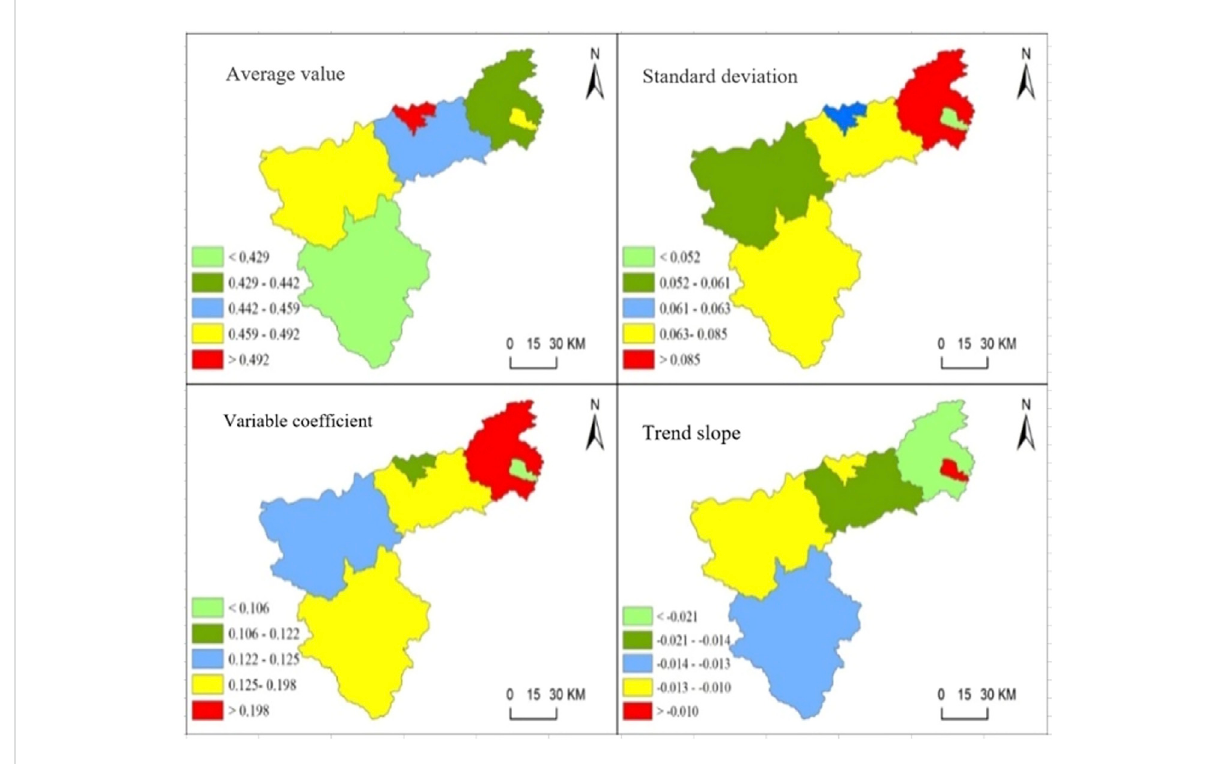
FIGURE 9 Degree of vulnerability changes in the farmland system in Sanmenxia City.